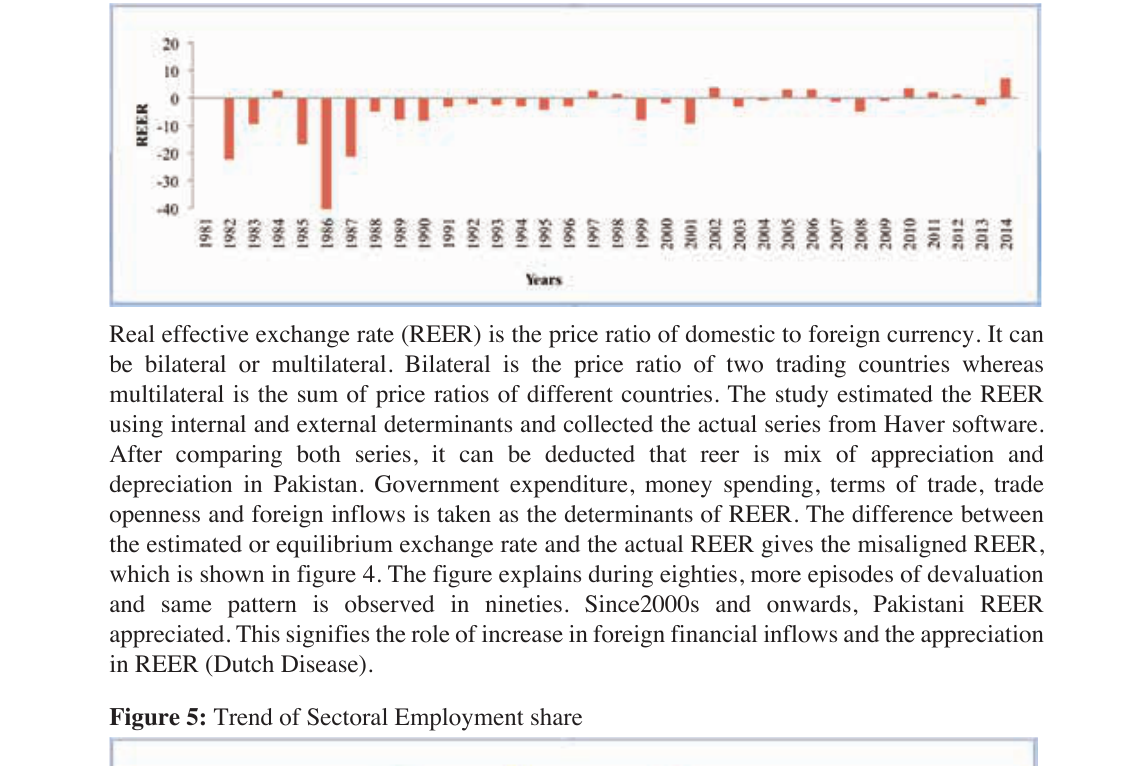
Figure 4: Trend of Real Effective Exchange Rate